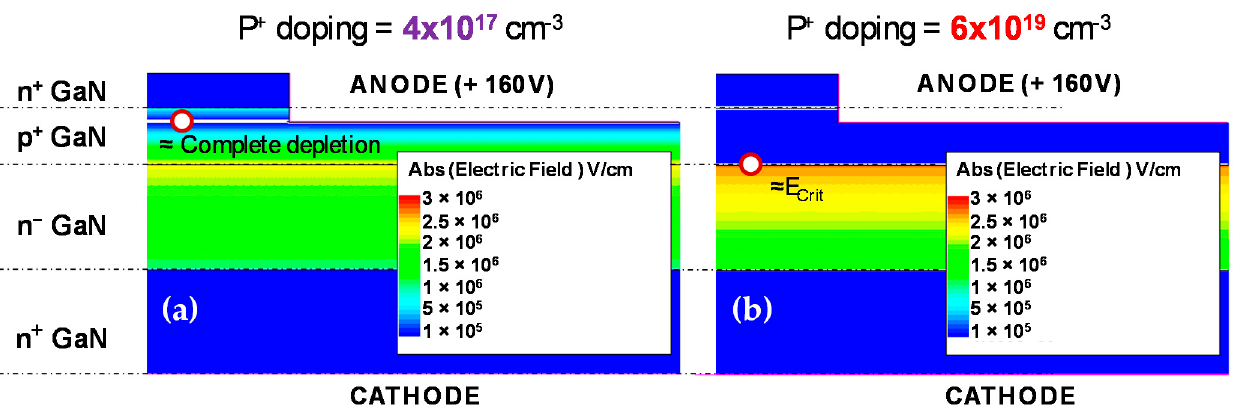
Figure 10. Two failure processes are identified from electric field profiles: ( a ) For lowly doped samples, punch-through occurs, due to the full depletion of the p-GaN, and ( b ) for high p-GaN, doping breakdown corresponds to the voltage for which the peak E-field at the p + n junction reaches the critical field of GaN.